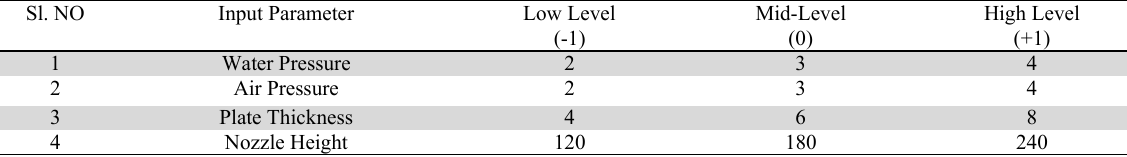
Input Parameters with their Coded value at different levels Sl. NO